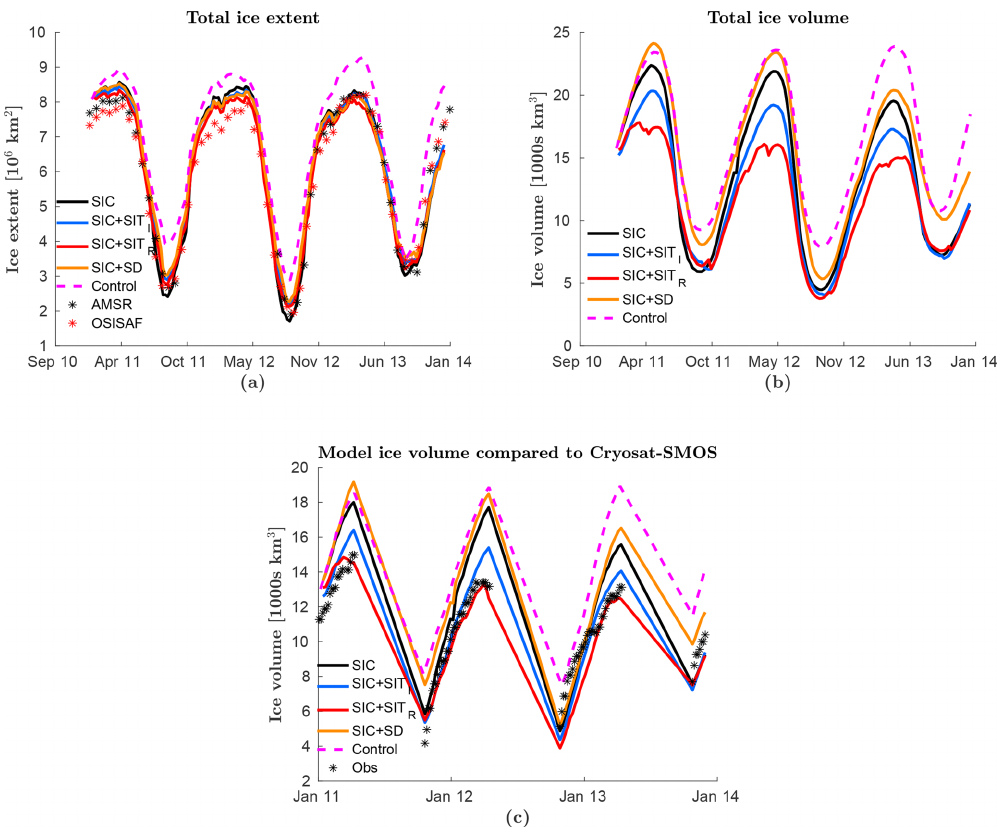
Figure 4. The evolution of (a) total sea-ice extent, (b) total sea-ice volume and (c) total sea-ice volume for the area covered by the CryoSat- 2-SMOS SIT observation product. The coloured lines represent the same as in Fig. 2. In (a) the black stars represent the AMSR-E/2 SIC observations and the red stars the OSISAF SIC observations. In (b) same as (a) without observations. In (c) the black stars represent the CryoSat-2-SMOS observation product. The x label is given as month and